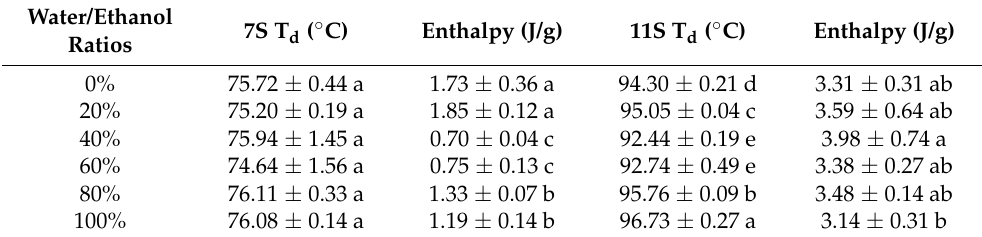
Table 2. The denaturation temperature and enthalpy of the transition of the soy protein concentrates